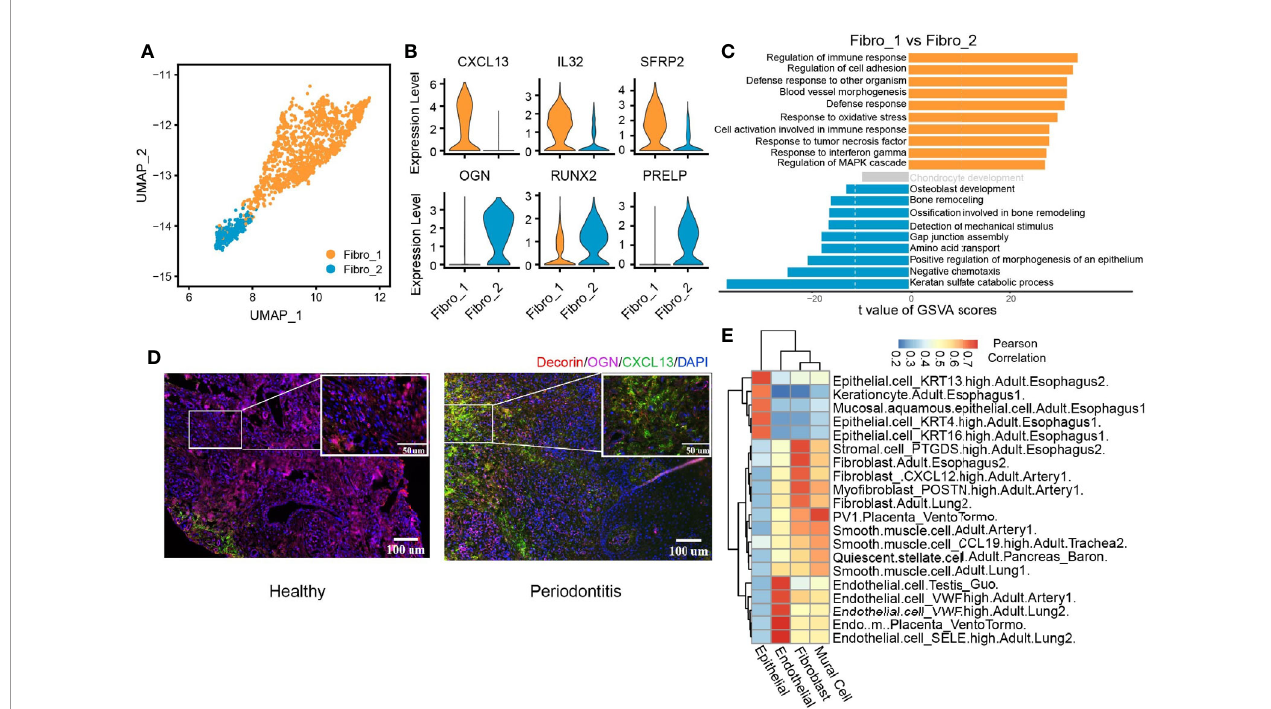
FIGURE 5 | CXCL13 + fi broblast subcluster associated with immune response. (A) UMAP visualization of two fi broblast subclusters in the combined health ( n = 2; 244 cells) and periodontitis ( n = 2; 1,260 cells) dataset. (B) Violin plots showing the expression distribution of selected genes associated with functions in the fi broblast clusters. The gene expression levels are normalized and transformed as ln (CPM/10). (C) Differences in pathway activities scored per cell by GSVA between fi bro_1 and fi bro_2. Shown are t values from a linear model, corrected for fi bro_1. (D) Immuno fl uorescent (IF) staining validation of fi broblast subtypes. Red shows the signal of decorin staining ( fi broblast marker); green shows the signal of CXCL13 staining; purple shows the signal of osteoglycin (OGN), and blue shows DAPI staining. Scale bar: 100 m m for main images and 50 m m for detail images. (E) Application of scHCL analysis for nonimmune cells. Each row represents one cell type in scHCL. Each column represents a cell cluster in our dataset. Pearson ’ s correlation coef fi cient was used to evaluate cell-type gene expression similarity. Red indicates a high correlation; blue indicates a low